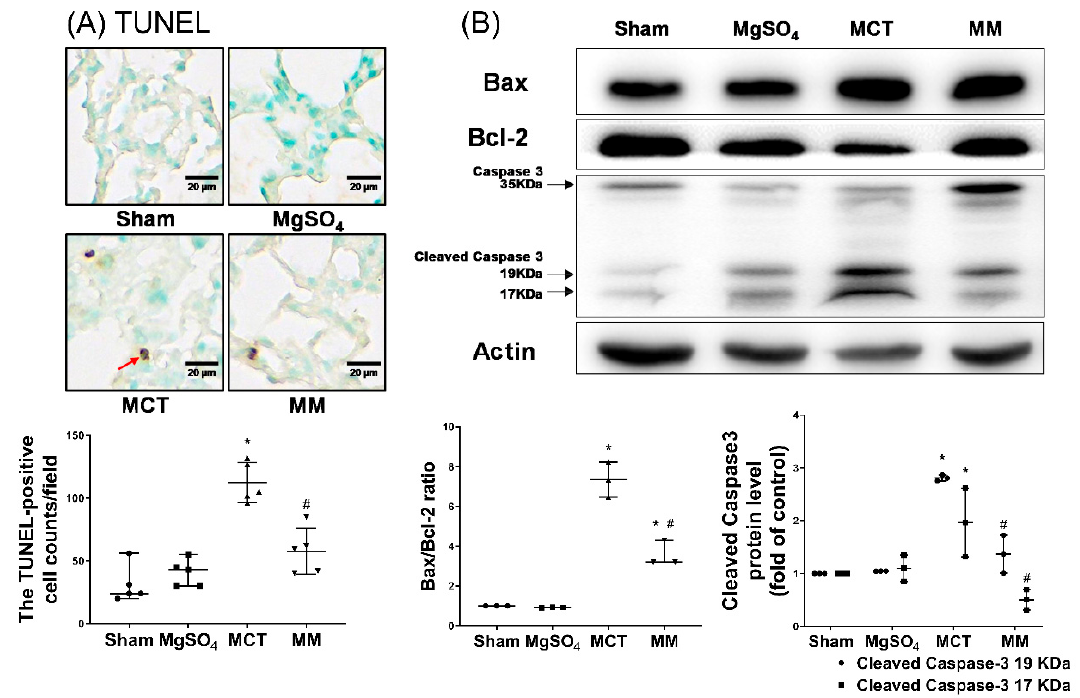
Figure 4. Magnesium sulfate (MgSO 4 ) mitigates monocrotaline-induced apoptosis in the lung tissues. ( A ) Representative microscopic images of DNA fragmentation in the lung tissues as assayed by the terminal deoxynucleotidyl transferase dUTP nick end labeling (TUNEL) method (200 × ). The red arrow indicates the representative image of TUNEL-positive nuclei. Mean TUNEL-positive cell counts (per 0.25 mm 2 ) are presented. ( B ) Representative gel photography of apoptosis-related proteins Bax, Bcl-2, caspase 3, and actin (internal standard) in the lung tissues obtained through immunoblotting assays. Bax / Bcl-2 ratios and relative cleaved caspase 3 / actin band densities are presented. Sham: normal saline group. MgOS 4 : MgSO 4 (100 mg / kg / day) group. MCT: monocrotaline (60 mg / kg) group. MM: monocrotaline (60 mg / kg) plus MgSO 4 (100 mg / kg / day) group. Data are expressed as median (range). Data of TUNEL and the apoptosis-related protein were obtained from five and three rats from each group, respectively. * p < 0.05 versus the sham group. # p < 0.05 versus the MCT group.